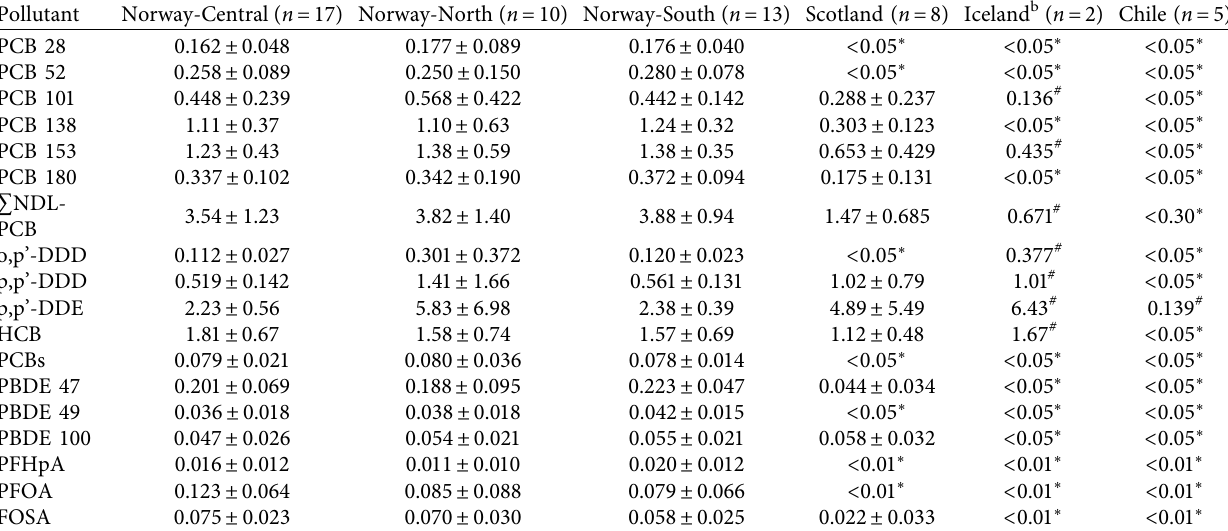
Table 3: Concentrations in μ g · kg − 1 wet weight for organohalogenated pollutants determined in Atlantic salmon from different origins.